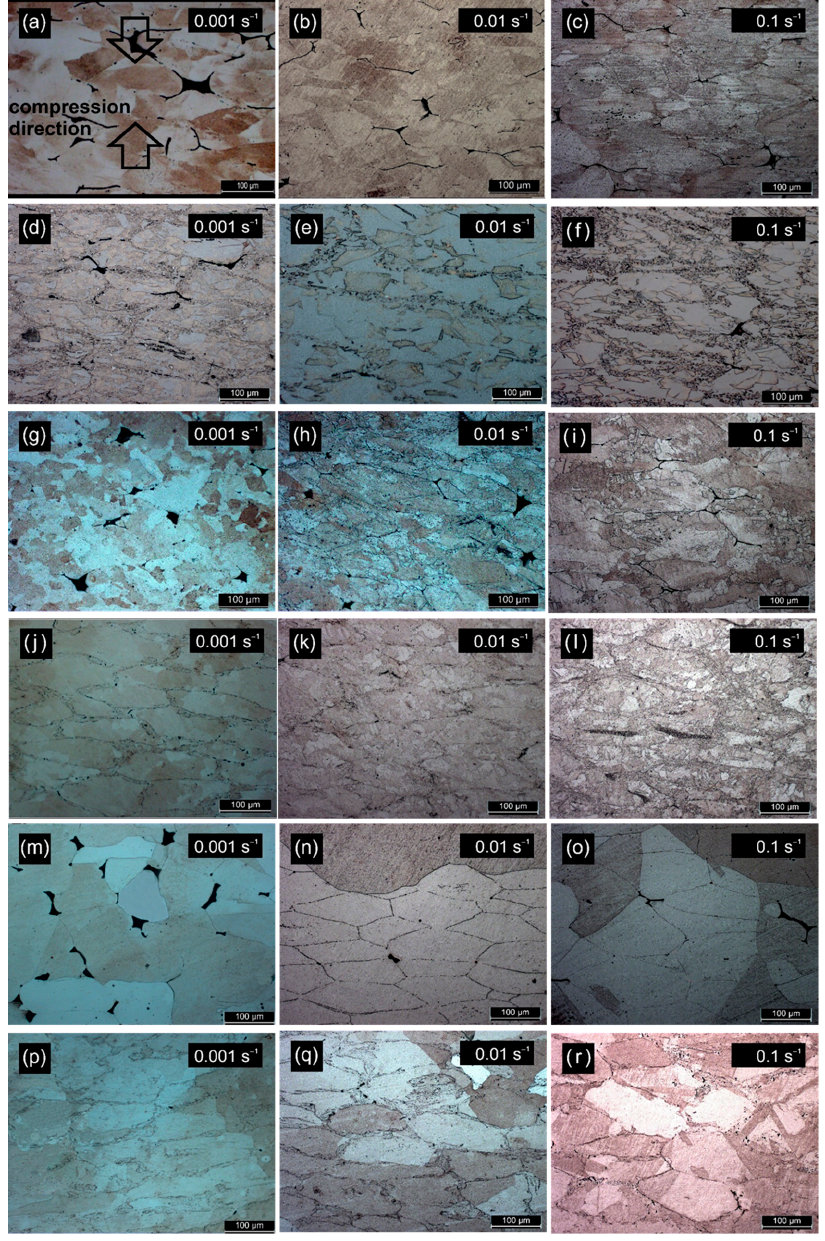
Figure 10. Microstructures of IP and MM deformed samples. ( a ) IP 400 °C–0.001 s − 1 ; ( b ) IP 400 °C– 0.01 s − 1 ; ( c ) IP 400 °C–0.1 s − 1 ; ( d ) MM 400 °C–0.001 s − 1 ; ( e ) MM 400 °C–0.01 s − 1 ; ( f ) MM 400 °C–0.1 s − 1 ;